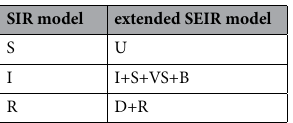
Table 1. Equivalence of the two epidemiology